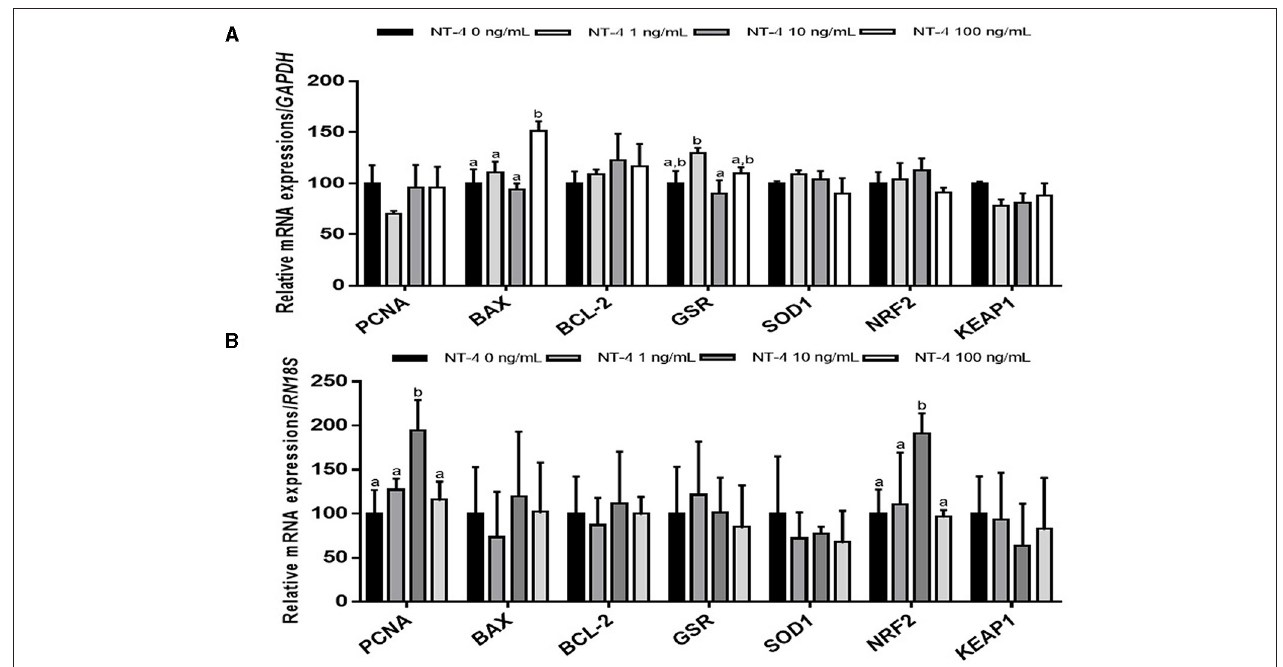
FIGURE 4 | Expression levels of proliferation, apoptosis, and antioxidant-related genes in neurotrophin-4 (NT-4)-treated cumulus cells and oocytes. Mean ± SEM expression of PCNA , BAX , BCL-2 , GSR , SOD1 , NRF2 , and KEAP1 mRNA in (A) cumulus cells and (B) oocytes. This experiment was replicated three times. Within each end point, bars with different letters (a and b) are significantly ( p < 0.05)